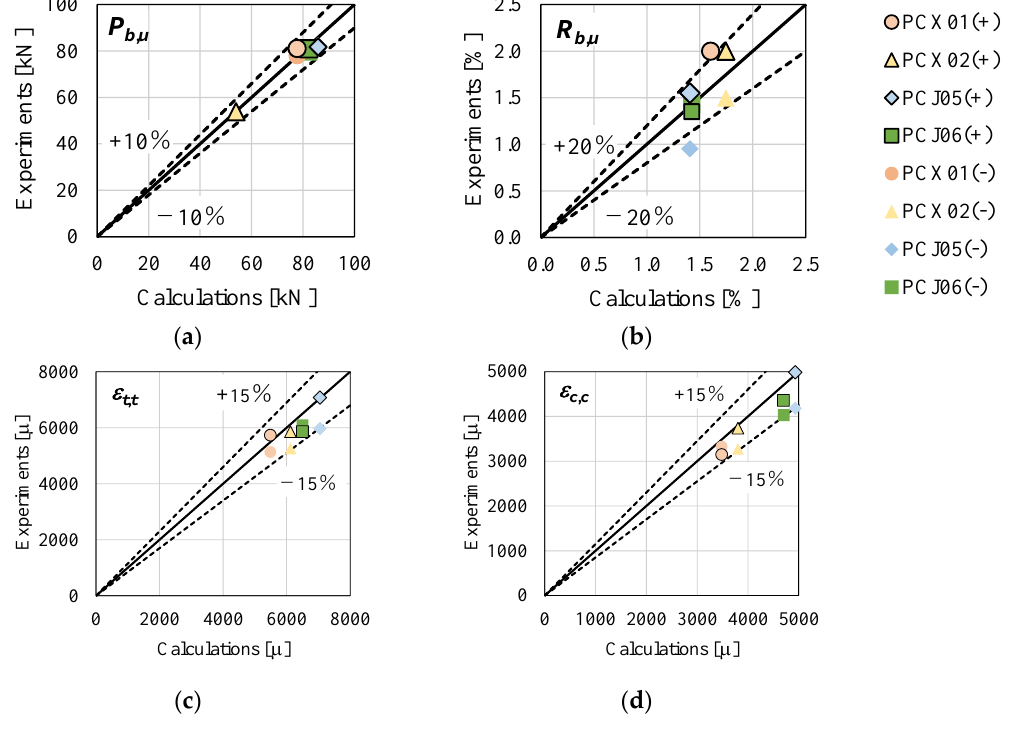
Figure 14. Comparison of iterative method results and test data: ( a ) beam shear forces; ( b ) beam deflection angles; ( c ) strain of tensile side tendons; ( d ) strain of compression side tendons.